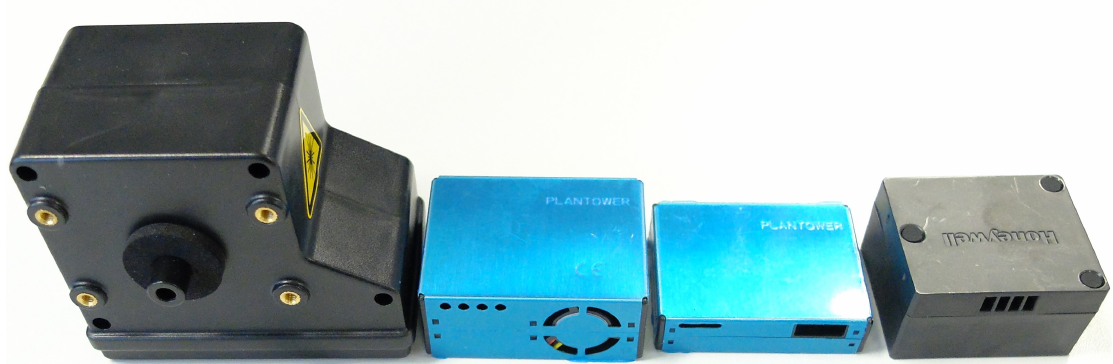
Figure 1. Particulate Matter (PM) sensors: Alphasense OPC-N2 [24], Plantower PMS5003 [25], Plantower PMS7003 [26], Honeywell HPMA115S0 [27].